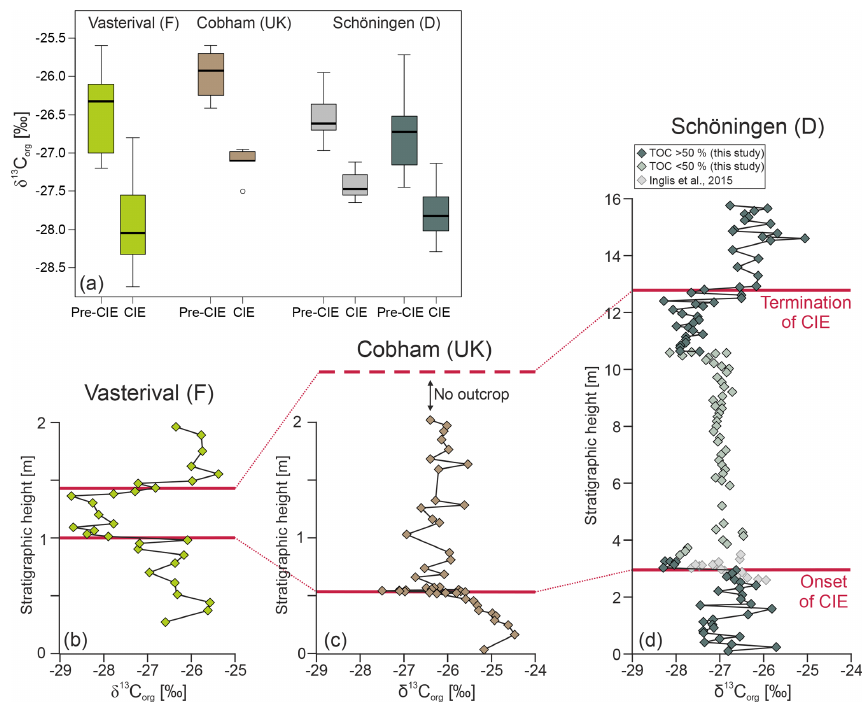
Figure 3. Comparison of midlatitudinal wetland δ 13 C TOC records surrounding the paleo-North Sea (see Fig. 1): (a) carbon isotopic dif- ferences at the onset of the CIE, (b) Vasterival, France (Storme et al., 2012), (c) Cobham, UK (Collinson et al., 2003), (d) Schöningen, Germany (this study: green symbols; Inglis et al., 2015: grey symbols). Note the different stratigraphic thicknesses due to different sediment accumulation and preservation conditions in the individual depositional